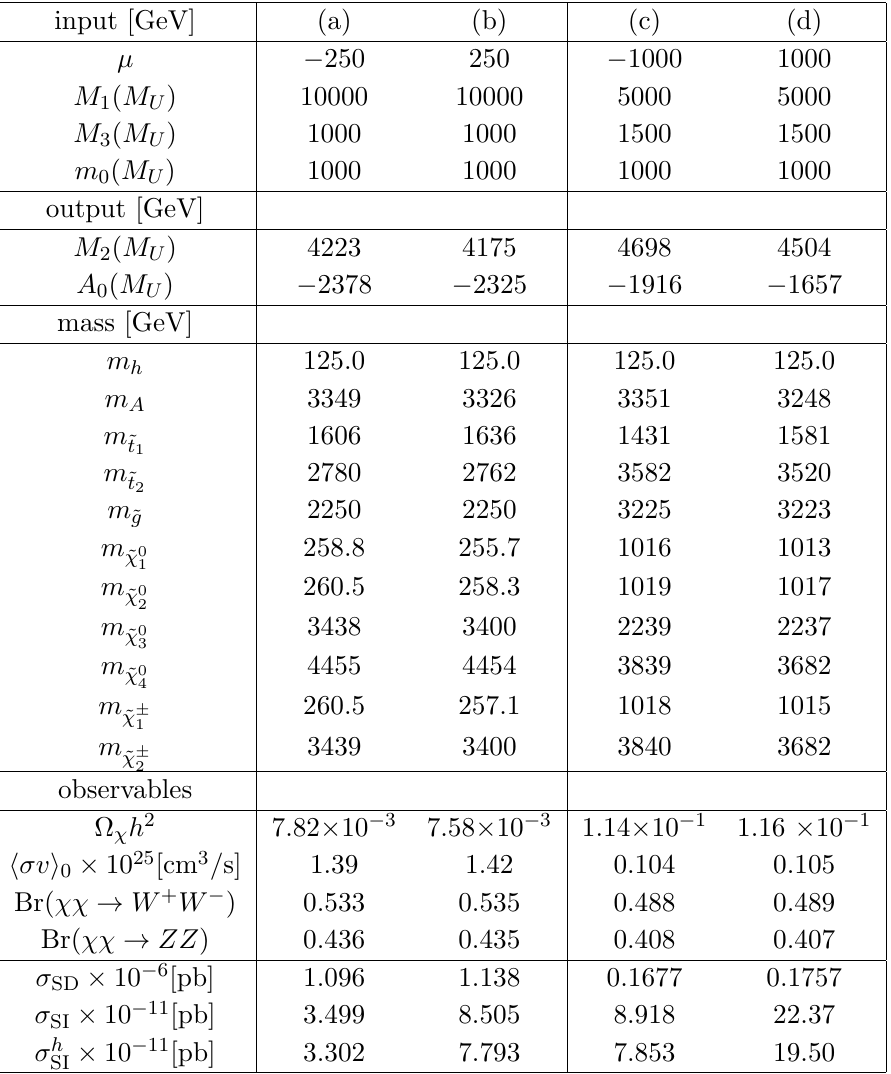
Table 1 . Values of boundary conditions at the uni(cid:12)cation scale M U , Higgs boson masses, sparticle masses and dark matter observables at several sample